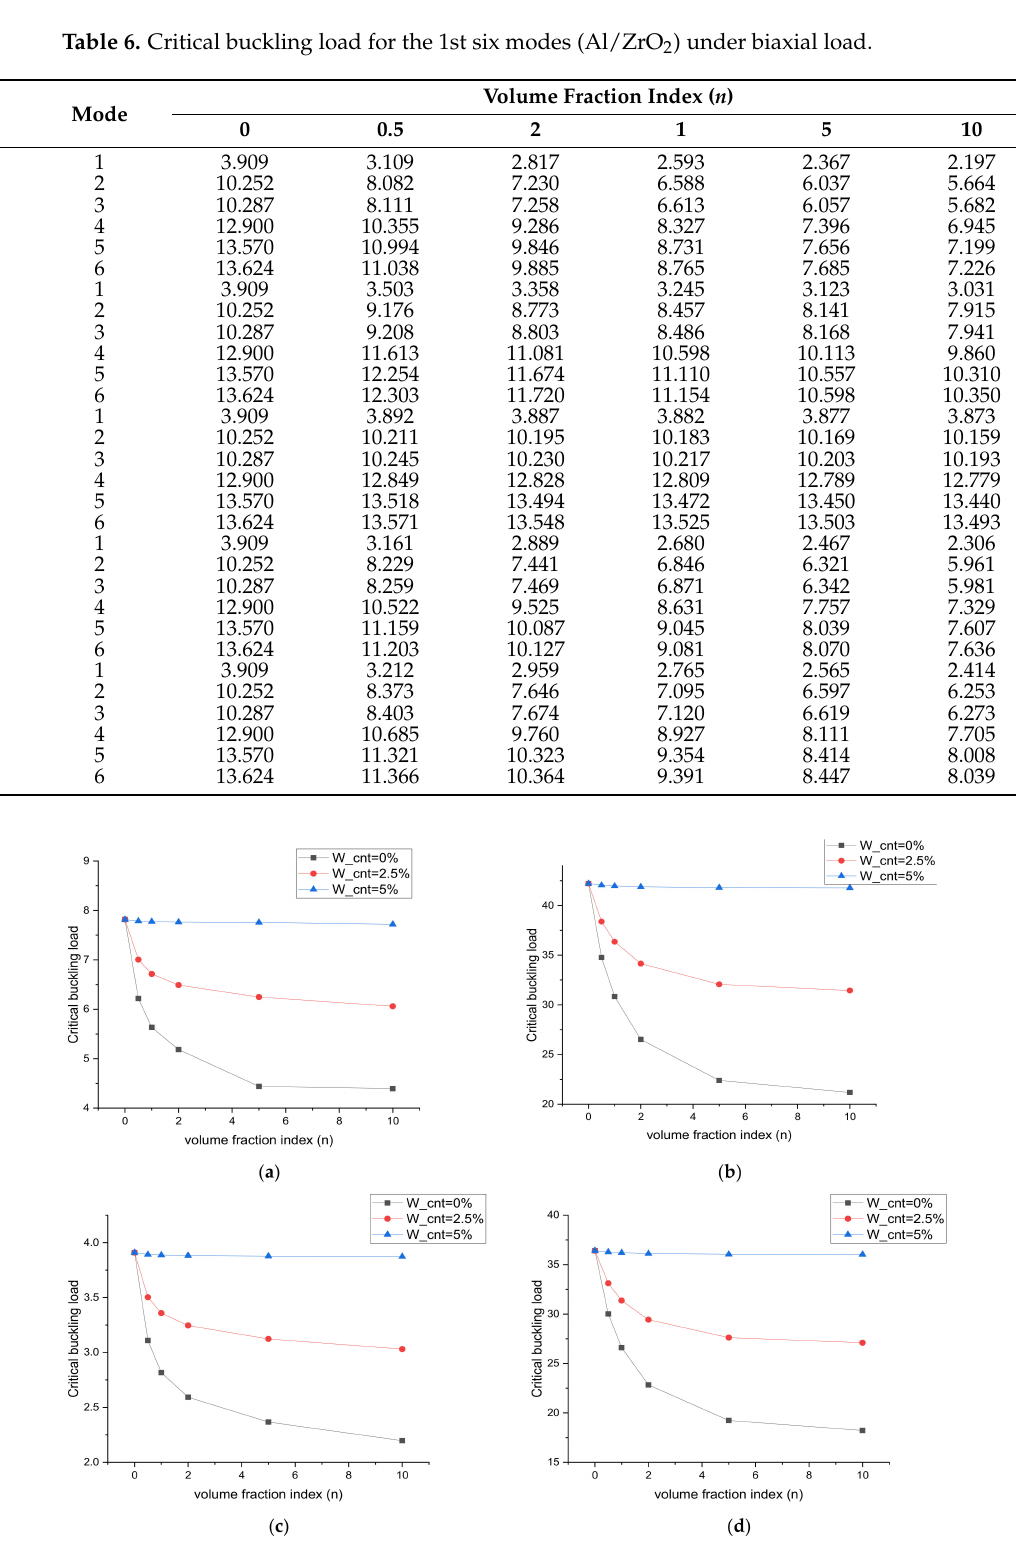
Figure 7. Variation in the critical buckling load for different fractions of CNT and fibers. ( a ) SSSS, ( b ) CCCC, ( c ) SSSS, ( d )